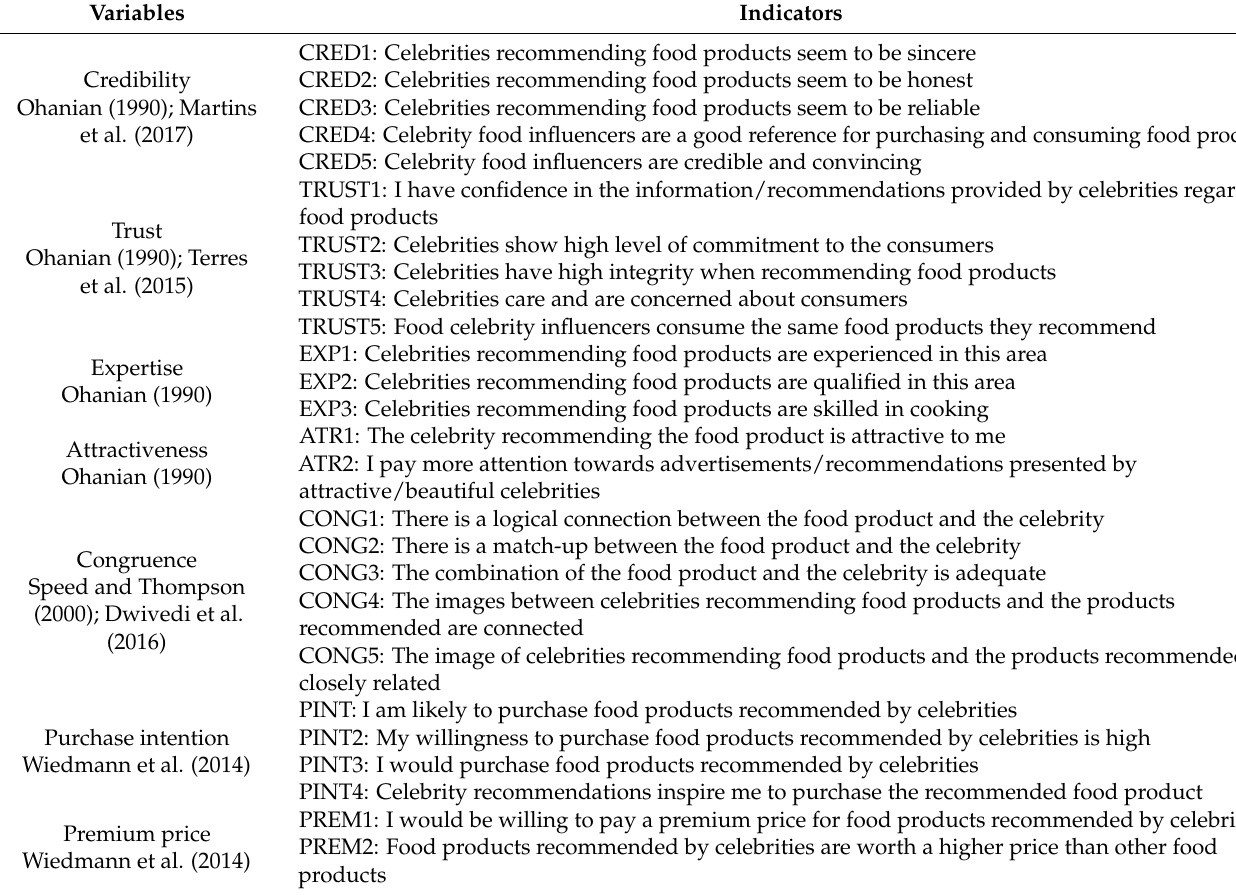
Table 1. Variables and